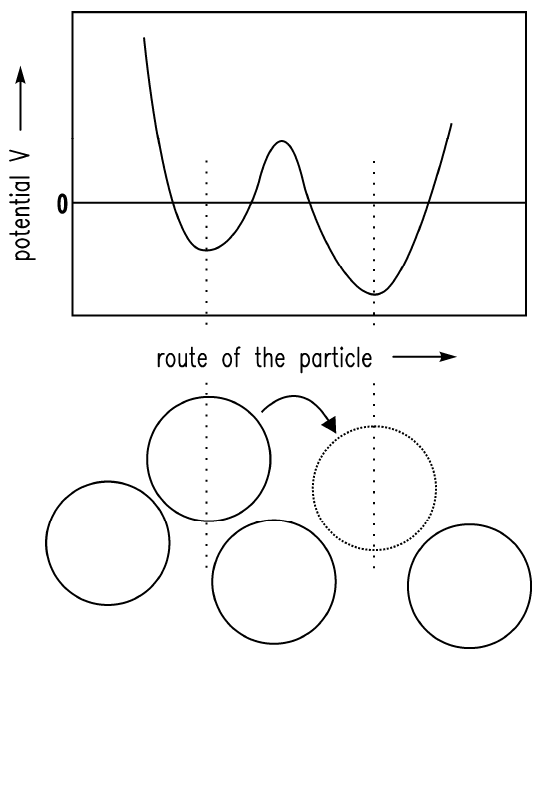
Figure 2. Schematic illustration of the particle